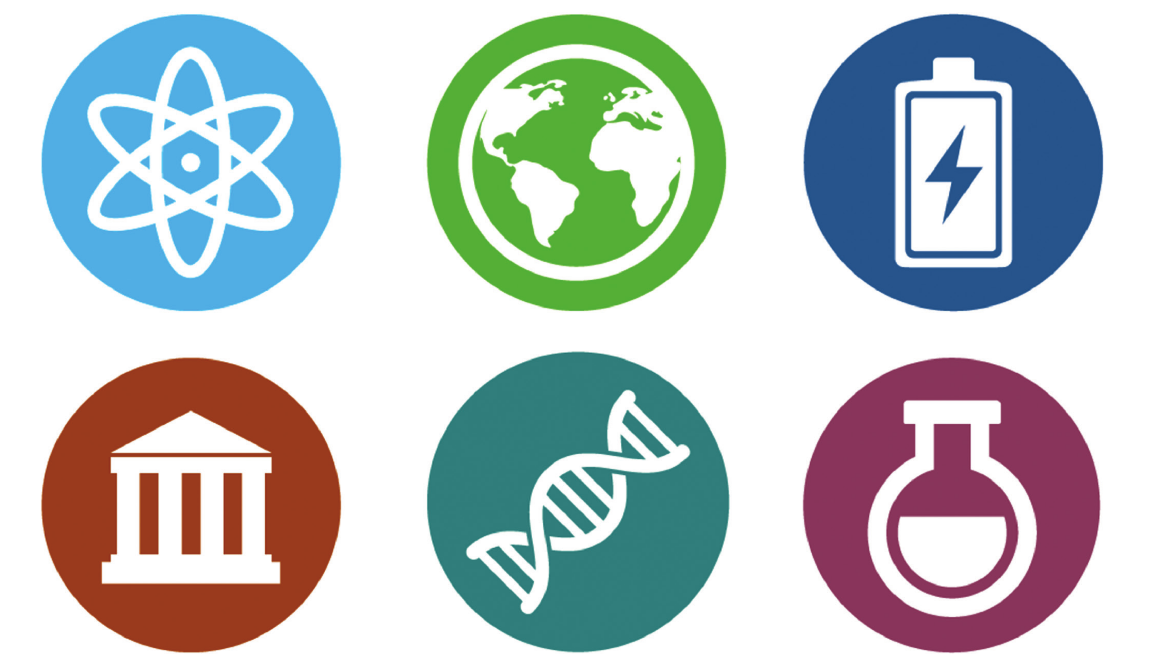
Figure 2. The main science icons, clockwise from top left: Physics, Earth science, Energy, Chemistry, Biology and Cultural heritage (Source: Authors, 2022; Diamond Light Source,